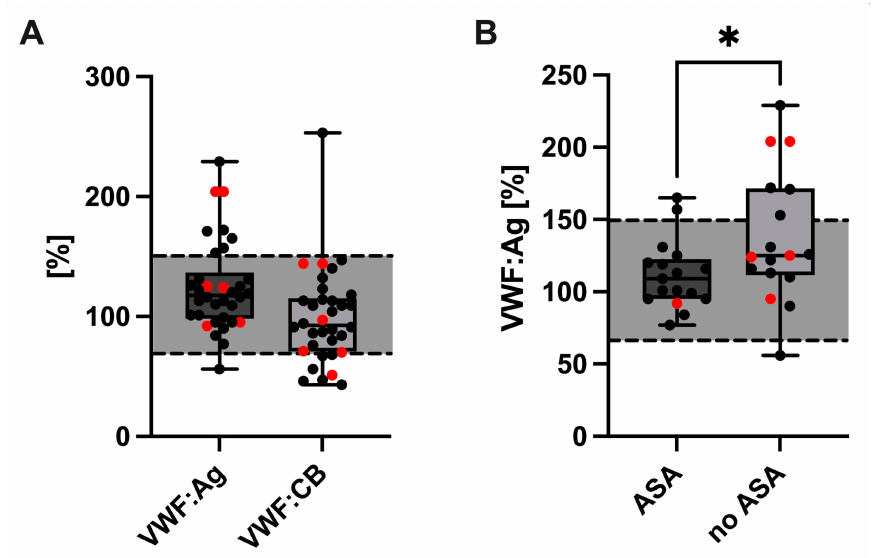
Figure 2. VWF:Ag and VWF:CB ( A ) values in cholestatic ( red dots ) and non-cholestatic Fontan patients. Comparison of VWF:Ag levels between Fontan patients with and without acetylsalicylic acid (ASA) treatment. Cholestatic patients are highlighted by the red dots ( B ). * p ≤ 0.05.